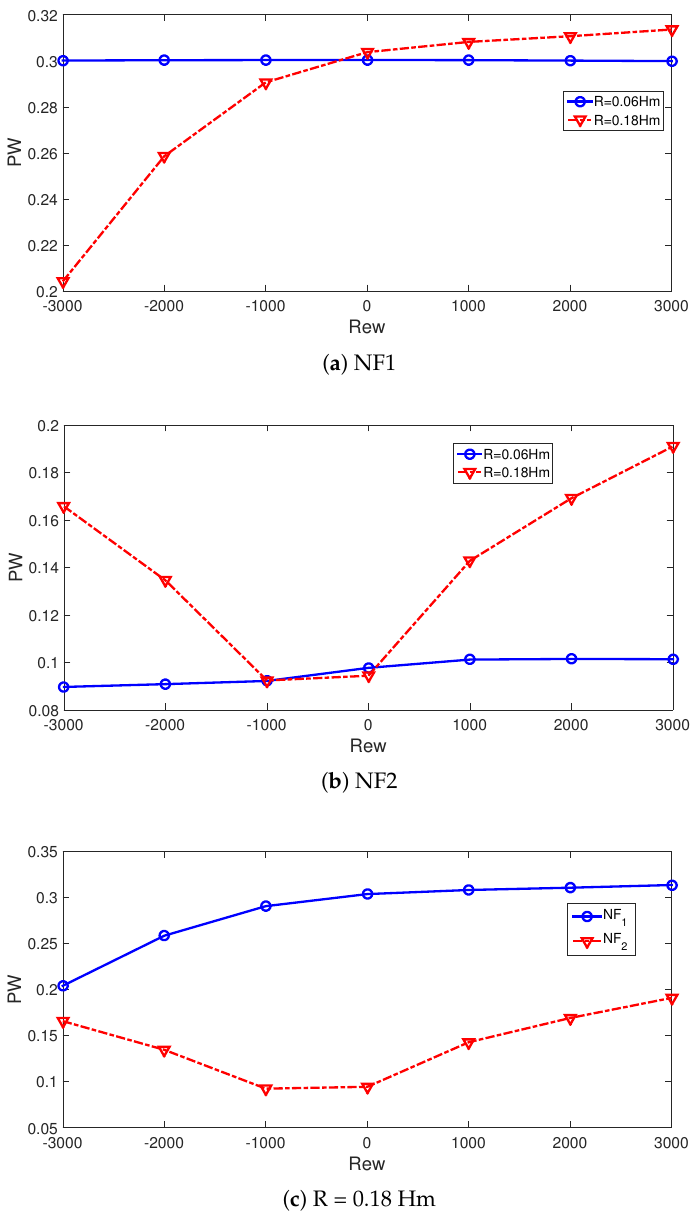
Figure 7. Generated power versus Rew for NF1 ( a ) and NF2 ( b ) with two different sizes ((Yp, Zp) = (0.5, 0.5)). The impacts of nanofluid type on the power generation versus Re ( c ) for (R = 0.18 Hm, (Yp, Zp) = (0.5,